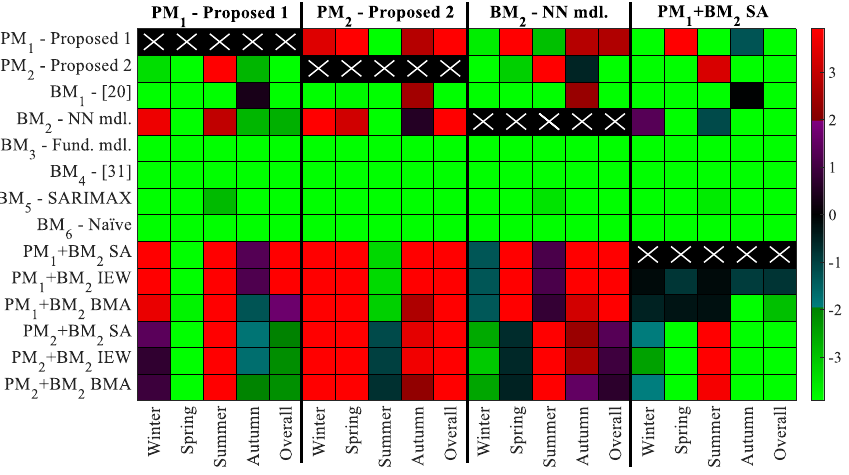
Figure 3. DM test for PM 1 , PM 2 , BM 2 and simple average of PM 1 +BM 2.